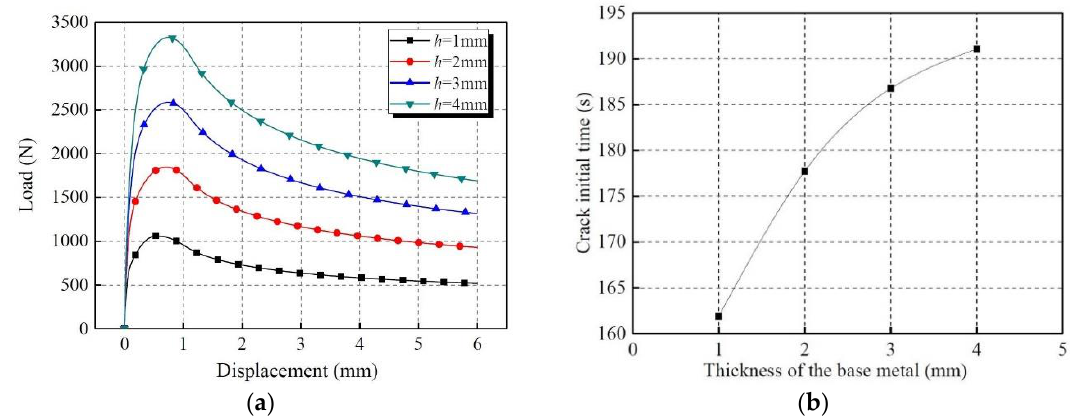
Figure 18. ( a ) Effect of base metal thickness on the load – displacement curve; ( b ) effect of base metal Figure 18. ( a ) E ff ect of base metal thickness on the load–displacement curve; ( b ) e ff ect of base metal thickness on the crack initial time. thickness on the crack initial time.